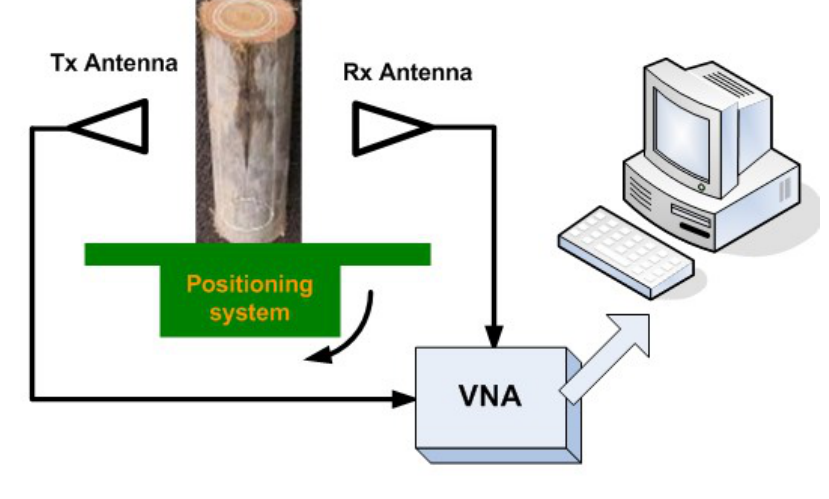
Figure 32. Block scheme of Pastorino microwave imaging system published in 2007.